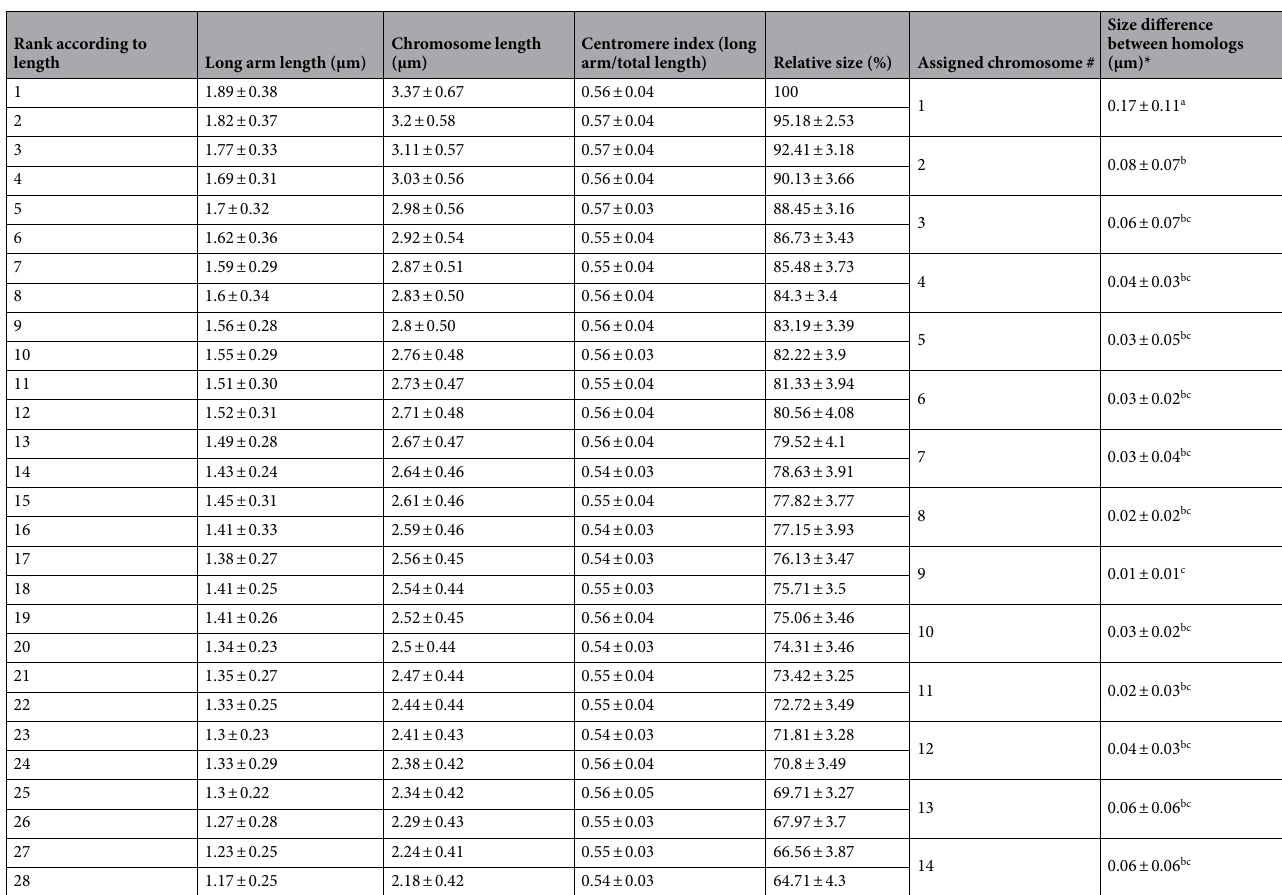
Table 1. Morphometric characteristics of the chromosomes of Acropora pruinosa (n = 20 metaphase spreads). *Different letters indicate significant differences ( P < 0.05). Details of the analysis are shown in Supplementary Table S1.